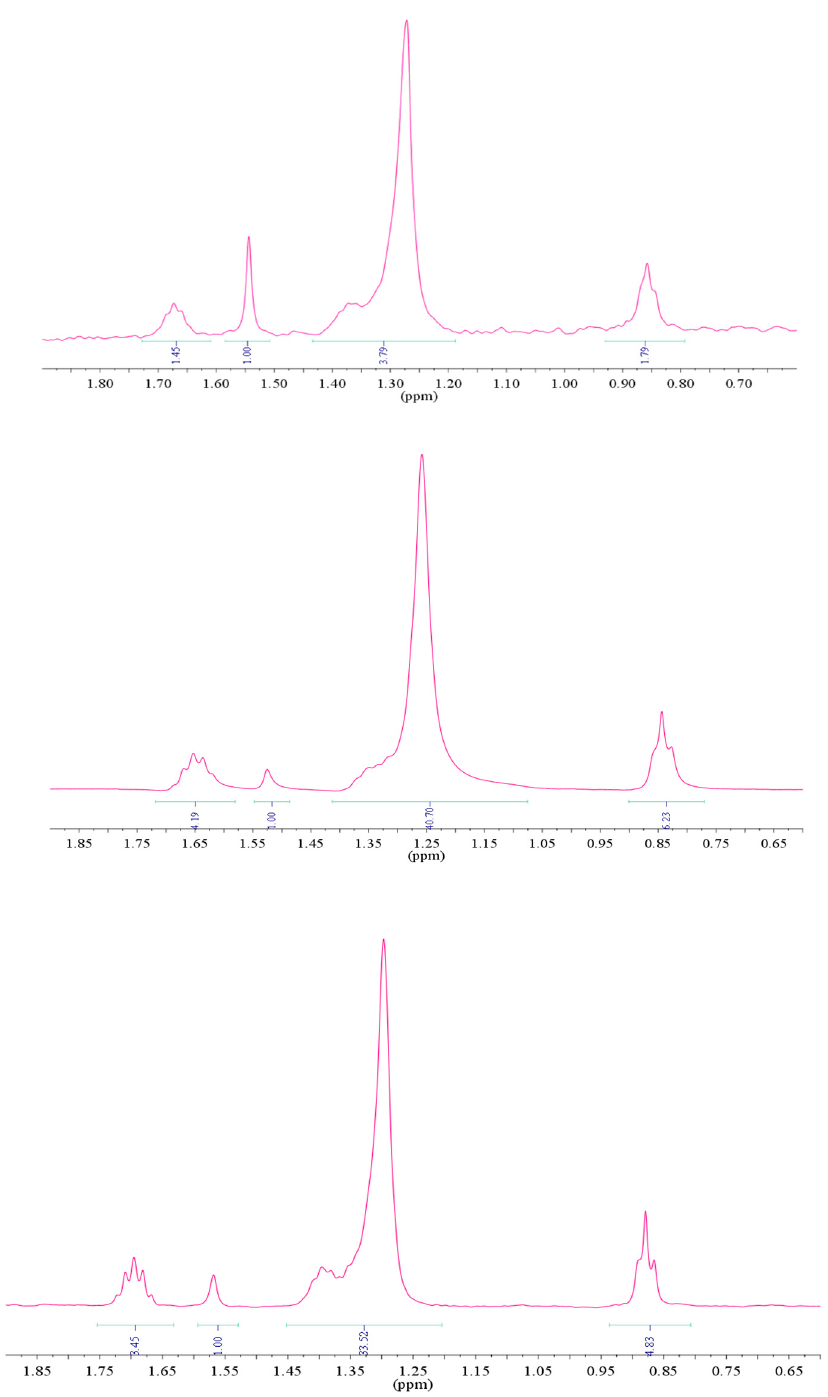
Figure 8. 1 H-NMR integrals comparison of aqueous solution related to (bottom to top) monomeric SDS , micellar SDS , and SDS / CTAB ( R = 1.85) at 30 °C. Integral values were referred to as the water included in CDCl 3 .